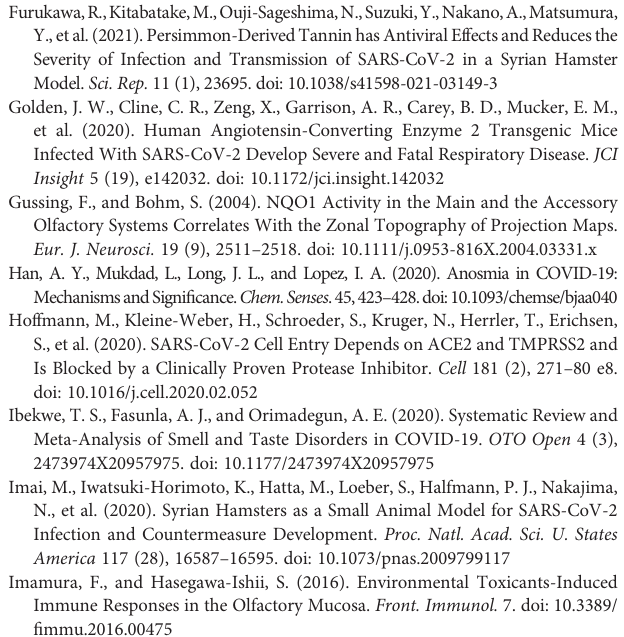
Supplementary Figure 1 | Double stained images of SARS-CoV-2 and OMP in the olfactory epithelium of the control hamster. Double stained images of SARS- CoV-2 and OMP in each region of the olfactory epithelium. The boxes in (A) indicate the regions of the olfactory epithelium shown in (B) ; the dorsal nasal septum (DS) area, ventral nasal septum (VS) area, dorsal lateral turbinate (DLT) area, and lateral turbinate (LT) area. No positive cells for SARS-CoV-2 are present in the olfactory